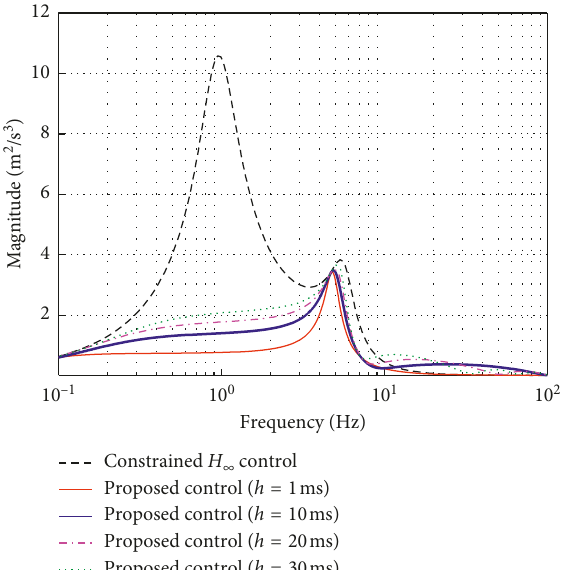
Figure 3: Frequency responses of car-body acceleration with different controllers.